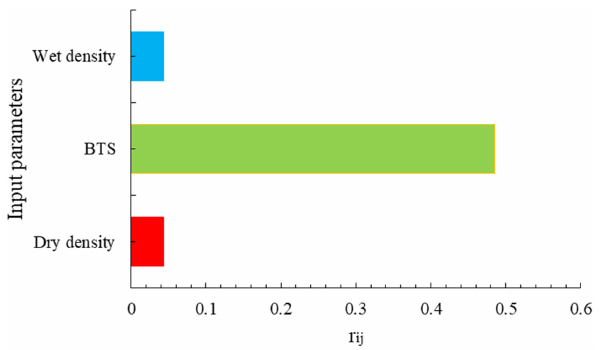
Figure 16. The e ff ect of input variables on the result of the established model. Figure 16. The effect of input variables on the result of the established